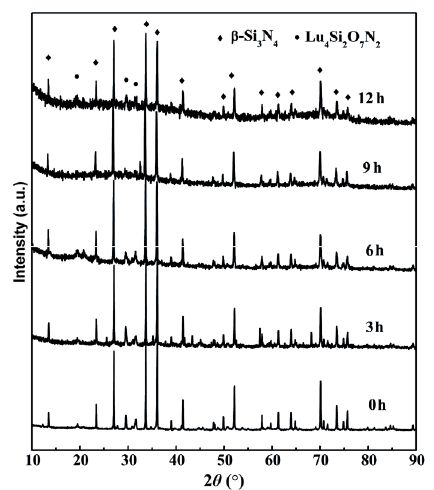
Fig. 4 XRD patterns of porous Si 3 N 4 –Si 3 N 4 composite ceramics as a function of deposition time.